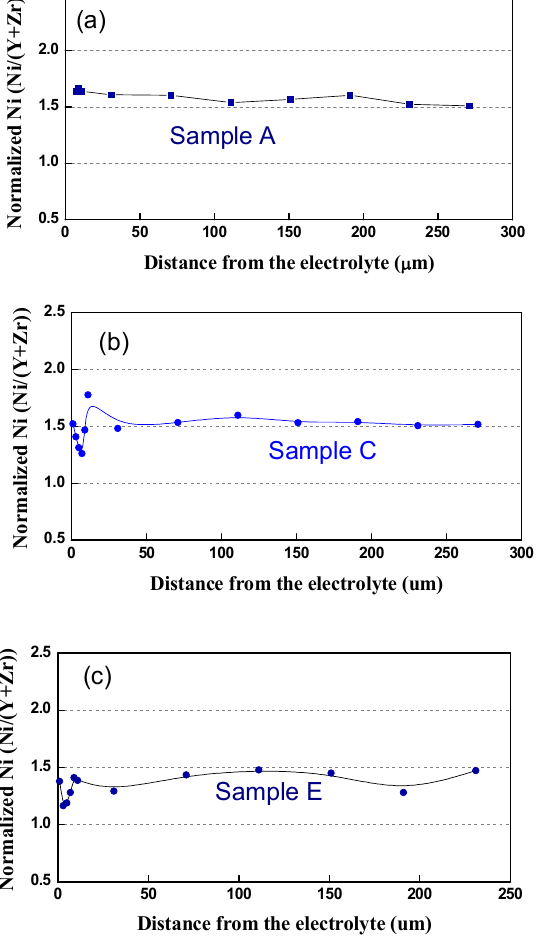
Figure 14. Normalized Ni content from the interface anode/electrolyte to the outer side: ( a ) Sample A (after initial reduction); ( b ) Sample C (3500 h); ( c ) Sample D (3000 h).